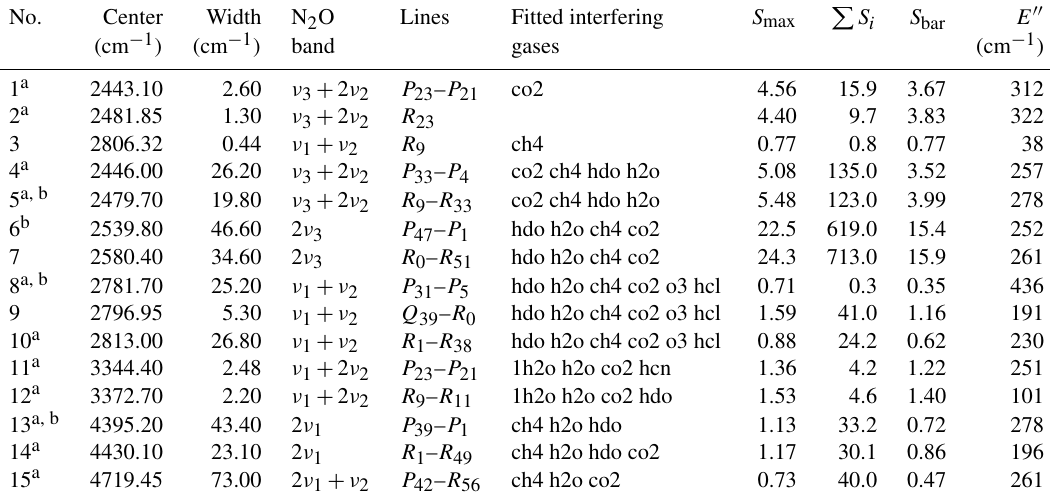
Table C1. Attributes of the 15 ground-based N 2 O spectral windows that were tested using MkIV ground-based spectra. Band defines the N 2 O band with the dominant lines in this window. Lines denotes the transition quantum numbers. S max is the maximum N 2 O line, P S is the sum of intensities, and S bar is the mean ( S -weighted) intensity, all in units of 10 − 21 cm − 1 (moleccm − 2 ) − 1 . E (cid:48)(cid:48) is the mean ( S -weighted) ground state energy in units of cm − 1 . These attributes are all independent of the measured spectra. A a in column 1 denotes windows that were accepted for subsequent analysis. A b in column 1 denotes windows whose averaging kernels are plotted in Fig. C1.